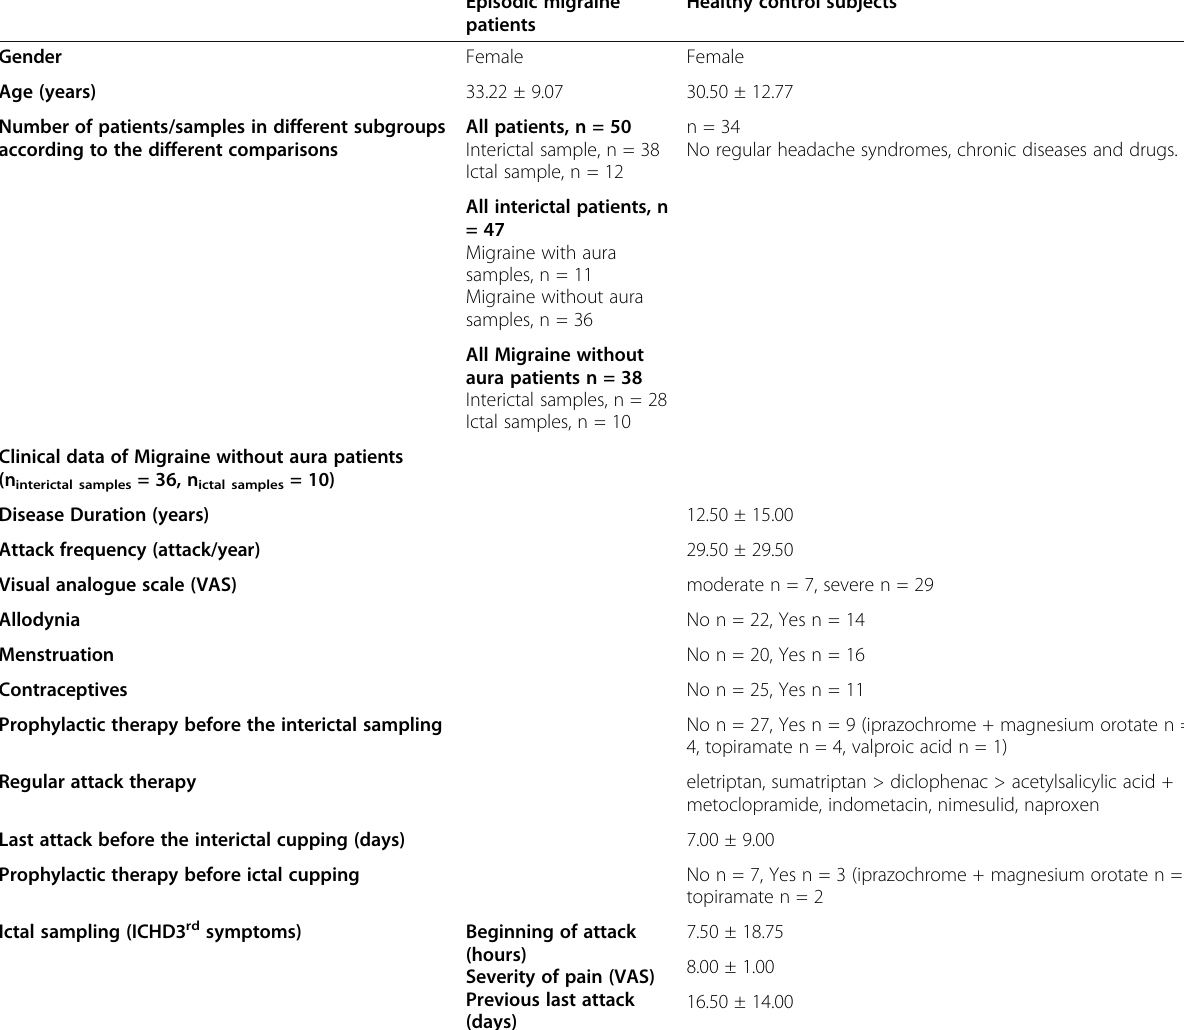
Table 1 General and clinical data of migraineurs and control subjects (median ± interquartile